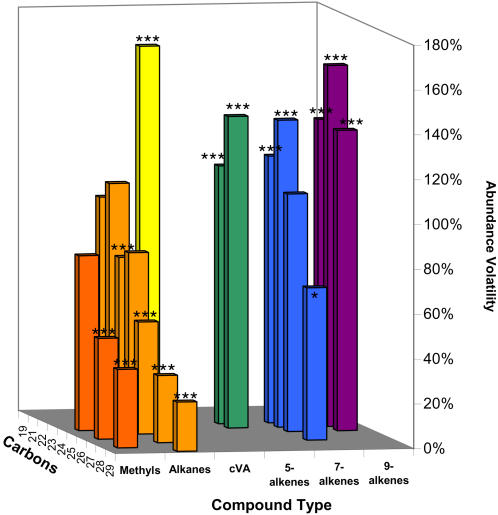
Abundance Variability AVj for 21 compounds in wild-type flies in DD.p(AVj>0)<10−7 in all cases. Methyl-alkanes and n-alkanes have significantly lower AV than monoenes at each chain length (p<10−6 in all cases), while longer chain compounds have lower AV than short chain compounds (e.g. AVC27 = 0.30<AVC23 = 0.74, p<10−11). Fitted to response for hours 0–23 using FA latent variable (see Methods). Asterisks indicate significant difference from the null hypothesis of AV = 100%. *** = p<0.001; ** = p<0.01.